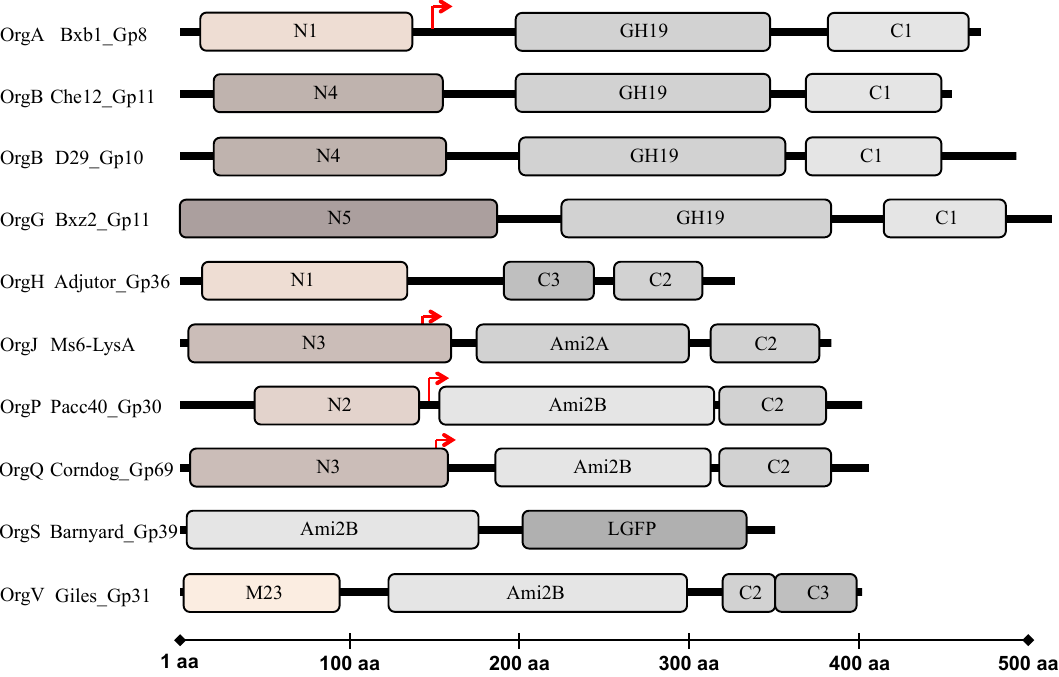
Figure 2. Modular organization of mycobacteriophage’s LysA proteins. Illustrated are representatives of mycobacteriophage endolysins with different domain combinations. The three predicted domains are differently colored. Putative peptidases: N1–N5 and M23 are shaded in beige; catalytic domains are marked with strip patterns; CWBDs are shaded in grey and LGFP repeats (suggested to be involved in cell wall anchoring) in dark grey. The red arrows indicate the start of the truncated versions of LysA. Coordinates of each domain were obtained from table S1 in a previous paper [47]. Protein accession numbers are: Bxb1_Gp8(AAG59713), Che12_Gp11(ABE67330), D29_Gp10(AAC18450),